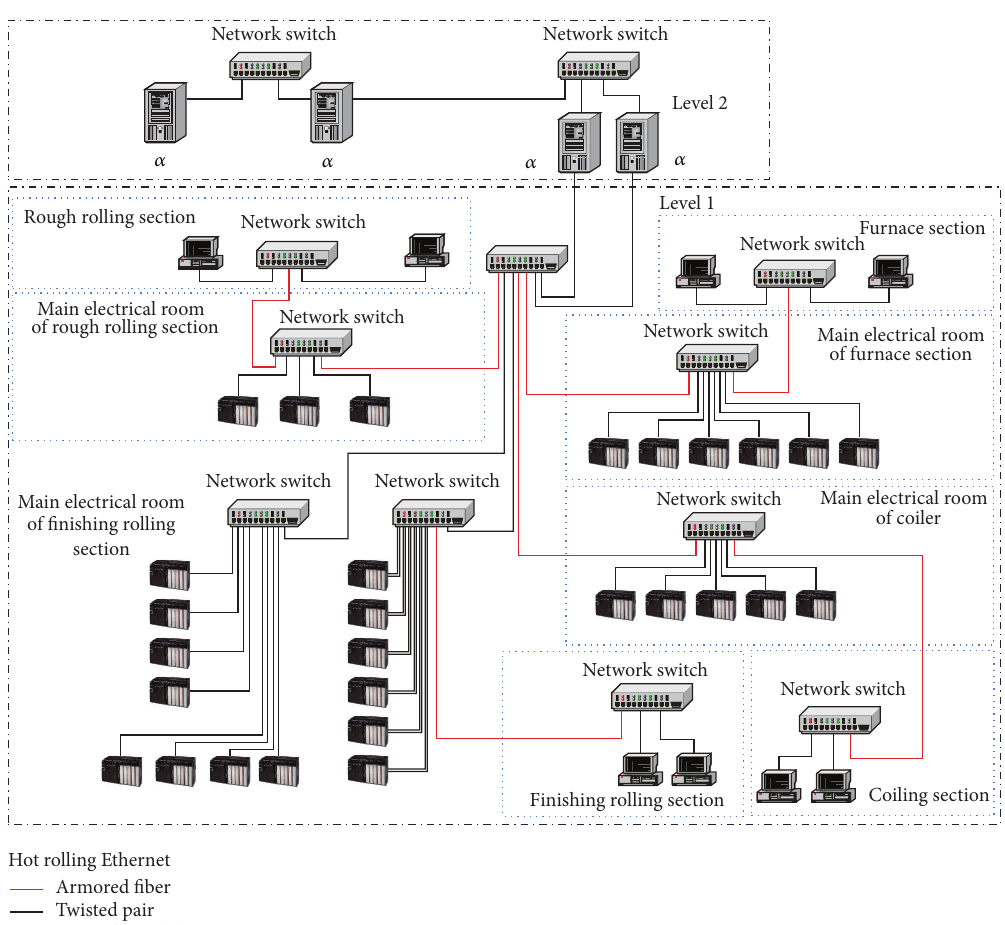
Figure 1: Ethernet network structure in a tandem rolling